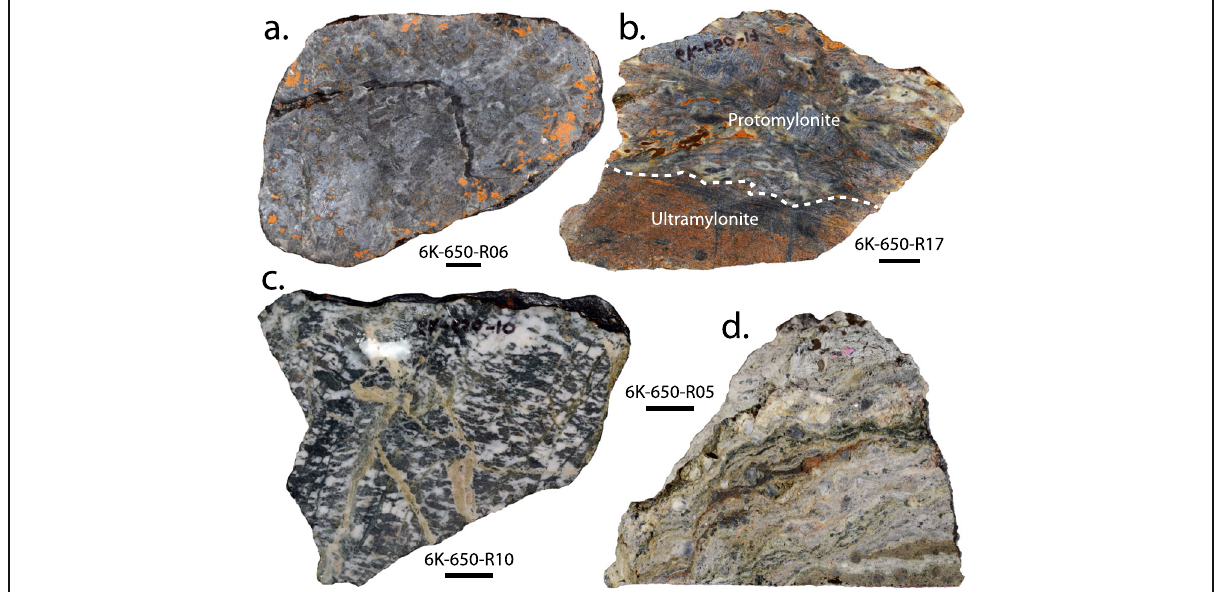
Fig. 22 Dive 650 gabbros: a Equigranular olivine gabbro with intergranular olivine weathered to bright orange clay on margins. b Olivine gabbro variably deformed from protomylonite to ultramylonite. c Amphibolite gneiss crosscut by zoisite (brown), actinolite/chlorite (pale green), prehnite (pink), and quartz veins. d Silicified gabbro cataclasite with hydrothermally altered pyroxene fragments, comminutated plagioclase, and milky quartz. Foliation defined by deformed mineral schlieren. Black bars = 1